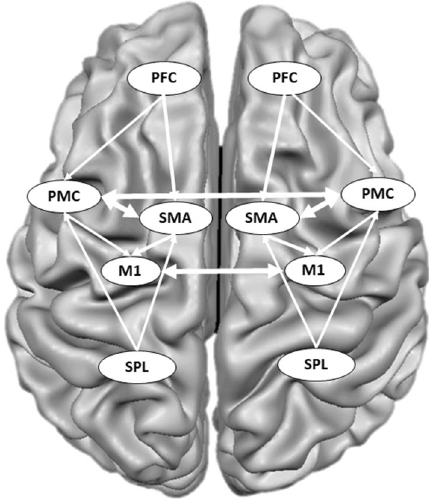
Figure 4. The regions of interest (ROI) of the motor network. The functional connectivity analyses included the following ROIs: prefrontal cortex (PFC), dorsal premotor cortex (PMC), primary motor cortex (M1), supplementary motor area (SMA), superior parietal lobe (SPL) (adapted from Sharma et al. 32 ). Altogether, this motor network consists of 14 intrahemispheric and 2 interhemispheric